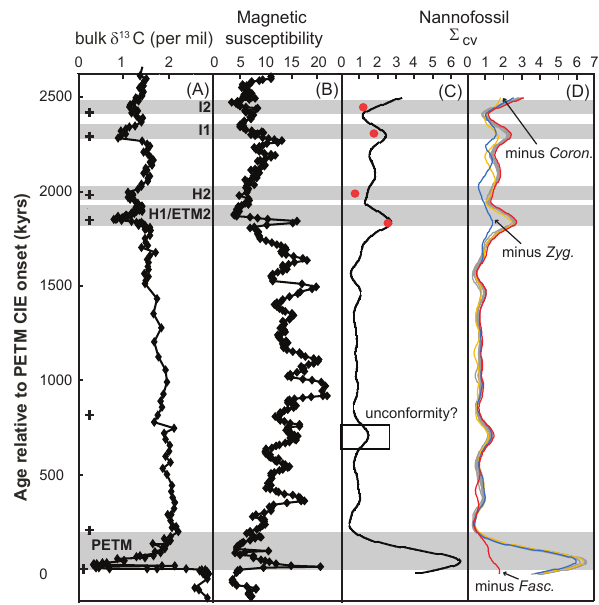
Fig. 2. Carbon isotope, magnetic susceptibility and calcare- ous nannofossil records from the Paleocene–Eocene interval at ODP Site 1209 plotted against age relative to the PETM onset. Panel (A) is the bulk carbonate carbon isotope record (Zachos et al., 2003; Murphy et al., 2006), with the CIEs highlighted in grey, and chronostratigraphic tie-points indicated by black crosses. Panel (B) shows magnetic susceptibility (Bralower et al., 2002). Panel (C) shows summed coefficients of variation ( 6 cv ) across age windows of 150kyr (in black), with values calculated across the duration of each CIE shorter than 150kyr, indicated by red cir- cles. Panel (D) is the 6 cv record excluding individual taxa: only the records excluding Coronocyclus (yellow), Zygrhablithus (blue) and Fasciculithus (red) are indicated in colour; the rest of the records are virtually indistinguishable from one another and are shaded in